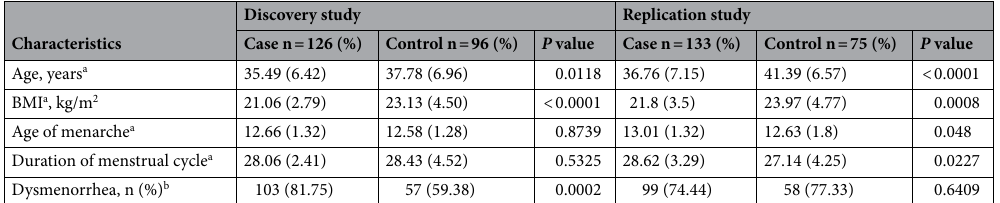
Table 1. Baseline demographic summary of women with endometriosis and control (n = 430). Mean (SD) for continuous variables. n (%) for discontinuous variables. BMI body mass index, SD standard deviation. a Mann– Whitney test. b χ 2